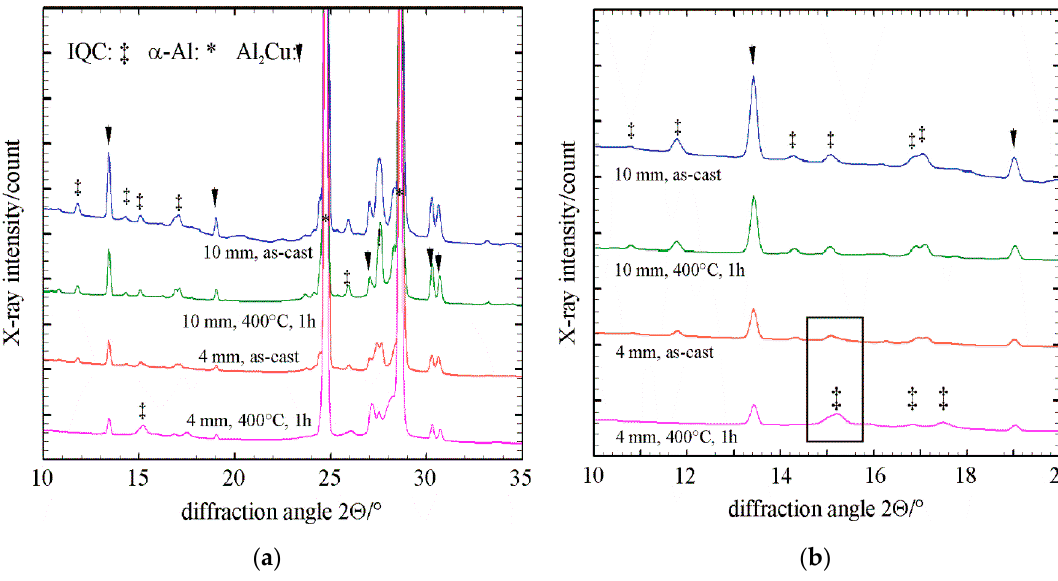
Figure 2. X-ray di ff raction patterns of di ff erent samples and conditions of the Al 95.4 Mn 1.8 Cu 1.6 Be 1.2 Figure 2. X-ray diffraction patterns of different samples and conditions of the Al 95.4 Mn 1.8 Cu 1.6 Be 1.2 alloy. ( a ) The range between 10 ◦ and 35 ◦ , and ( b ) the range between 10 ◦ and 20 ◦ that shows clearly the alloy. ( a ) The range between 10° and 35°, and ( b ) the range between 10° and 20° that shows clearly positions and shapes of minor phases’ the positions and shapes of minor phases’ peaks.